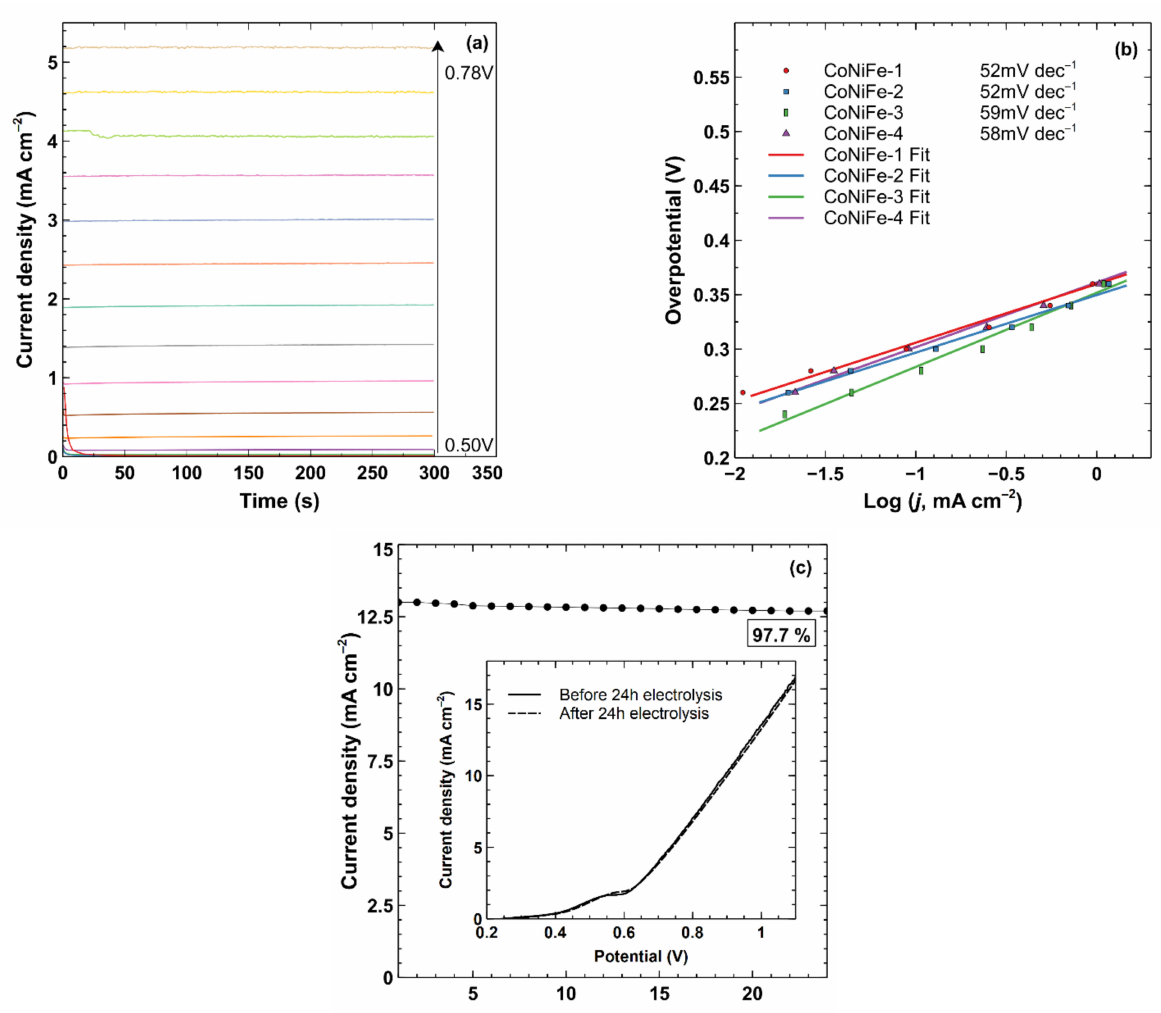
Figure 5. ( a ) Potential-controlled electrolysis of the CoNiFe-1 coating in 0.1 M NaOH. ( b ) Tafel plots of the Co-Ni-Fe oxide coatings in 0.1 M NaOH. ( c ) Long-term electrolysis results of CoNiFe-1 with LSV scans before and after